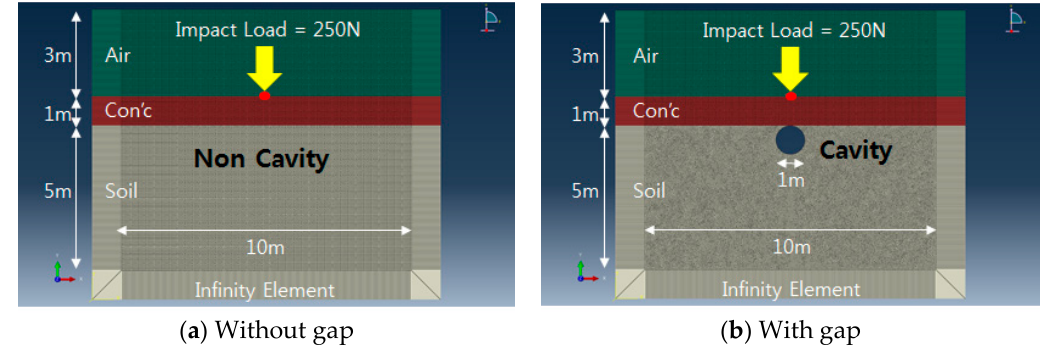
Figure 1. Finite element modeling of railway track slab. ( a ) Without gap. ( b ) With gap.